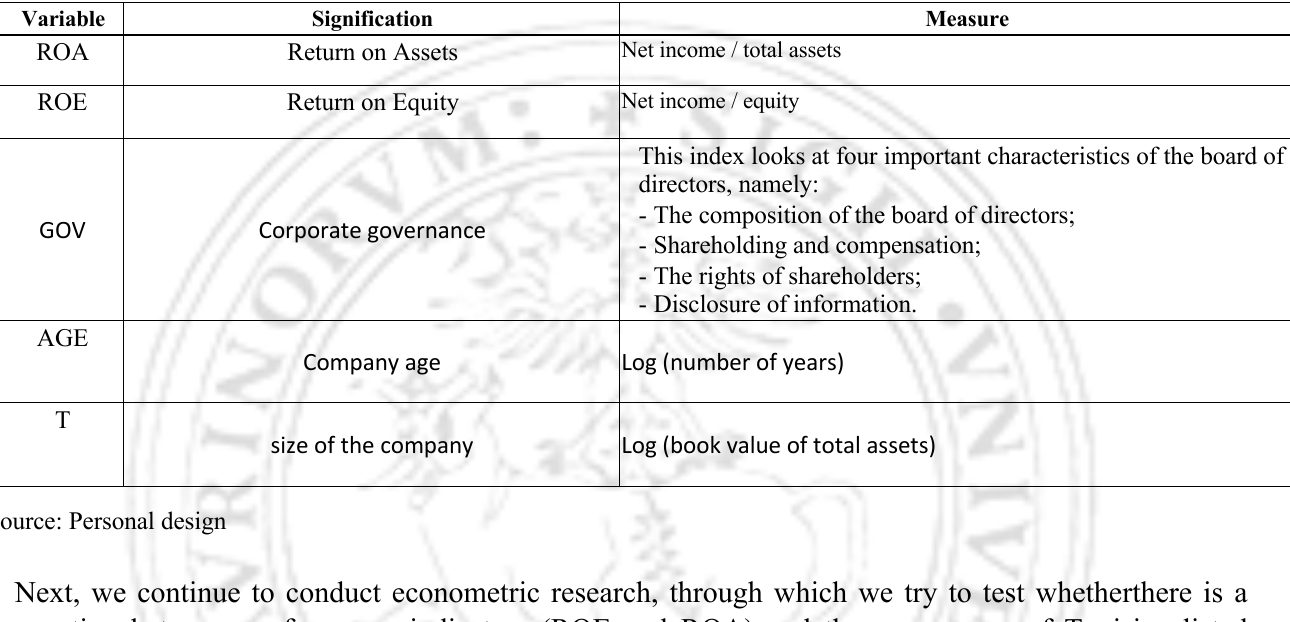
Table 1: variable choice’s